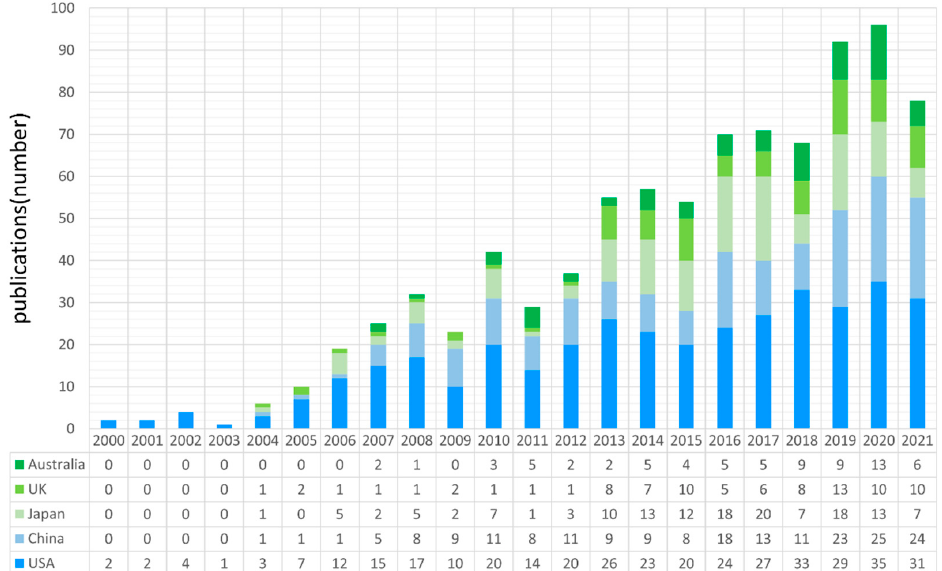
Figure 2. Publications in TOP 5 publication countries during 2000–2021. The number of annual publications of the five countries with the highest number of publications is shown.